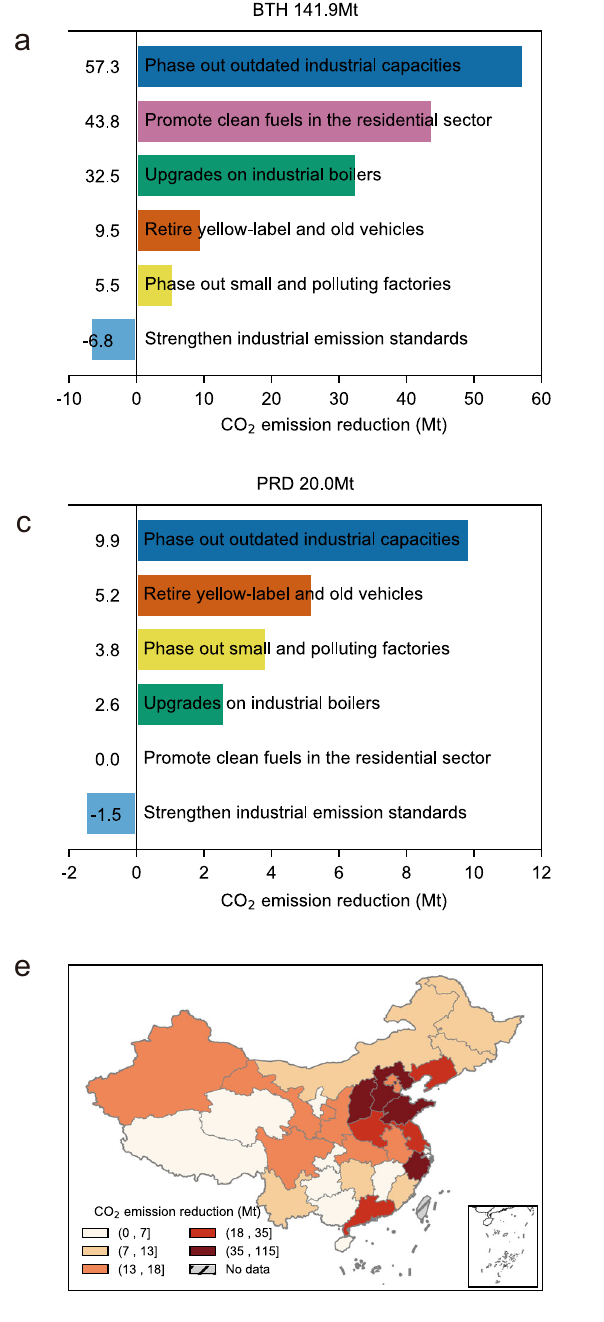
representing the CO 2 emission reduction in 2020 and the color representing the proportion of CO 2 emission reduction to real local CO 2 emissions in 2020. The policy effectiveness provides a general measure of the policy intensity in a region, with the coef fi cient value ranging from 0 (very weak) to 1 (very strong), and more details are presented in Supplementary Note 1 and Supplementary Tables 2 and